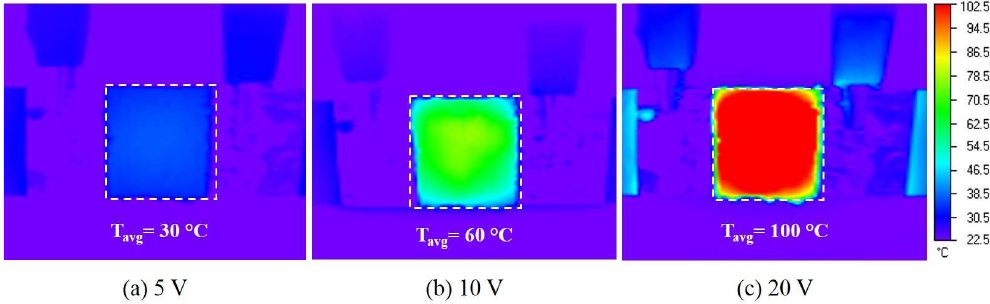
Figure 5. Temperature profiles of CNT nanocomposites cured at different voltages showing rapid temperature increase during the initial linear region and steady temperature states in the long term.